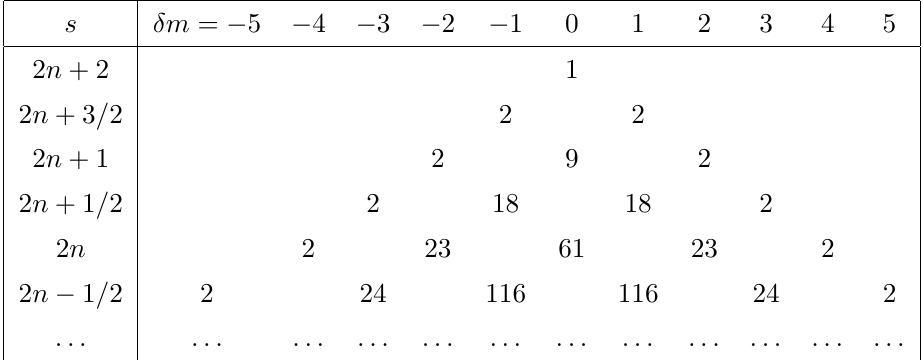
Table 1 . Multiplicity of the N = 4 multiplets that arise along the (cid:22) r = 0 edge for the case where j 0 and hence m is su(cid:14)ciently big. Here and below the spin always refers to the spin s of the ‘top’ component of the N = 4 multiplet | the bottom component then has spin s (cid:0) 2.